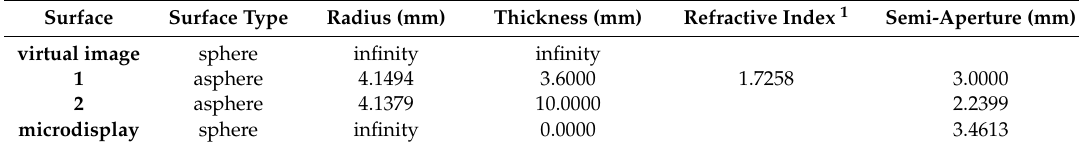
Table 4. Optical surfaces used in the simulation of the virtual image.